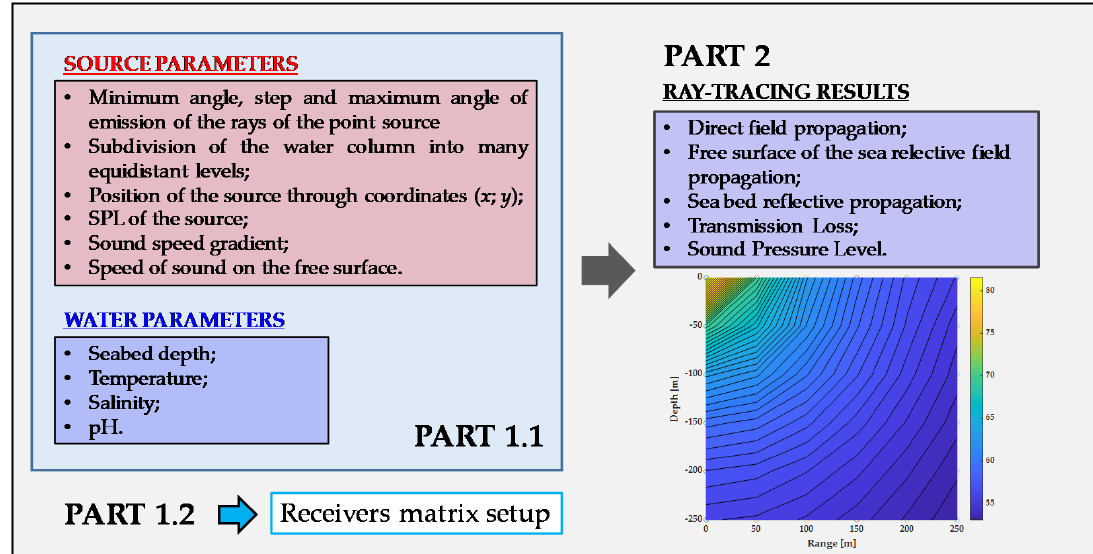
Figure 3. Logical schematic of the numerical code.